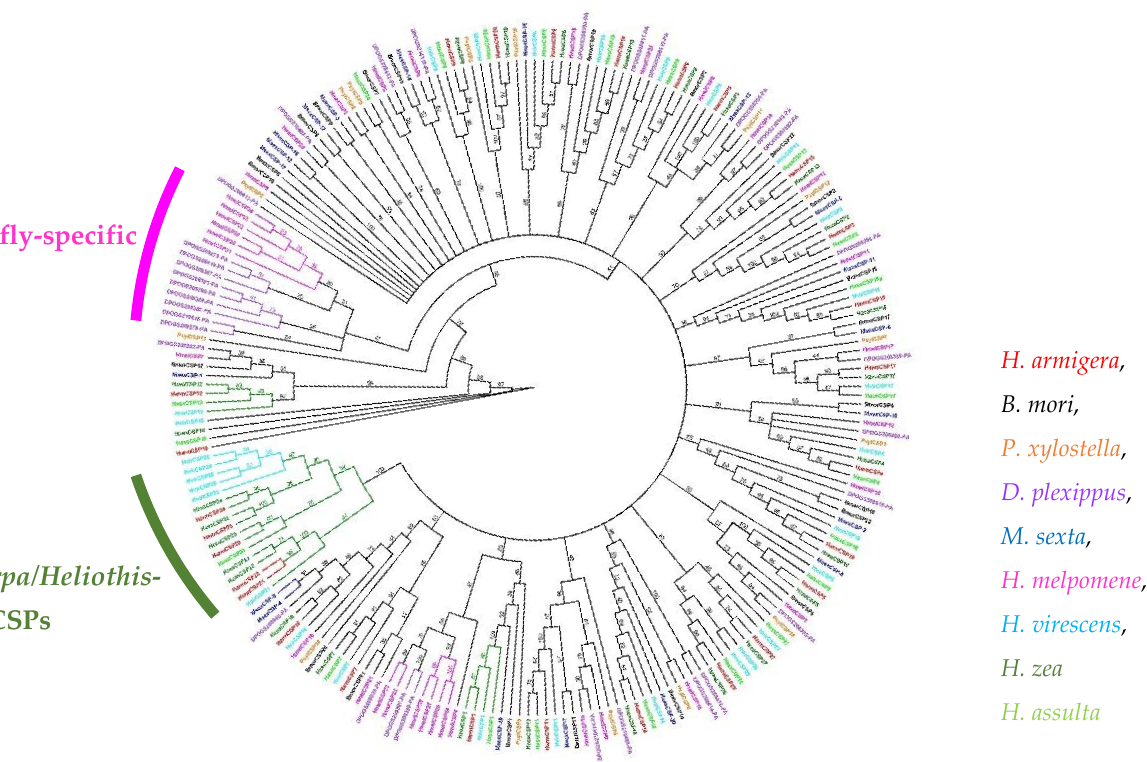
Figure 1. The maximum-likelihood phylogenetic analysis of selected lepidopteran CSPs from: H. armigera , B. mori , P. xylostella , D. plexippus , Manduca sexta , H. melpomene , Heliothis virescens , H. zea , and H. assulta (Supplementary Data S1). The amino acids of these CSPs are given in the supplementary data.